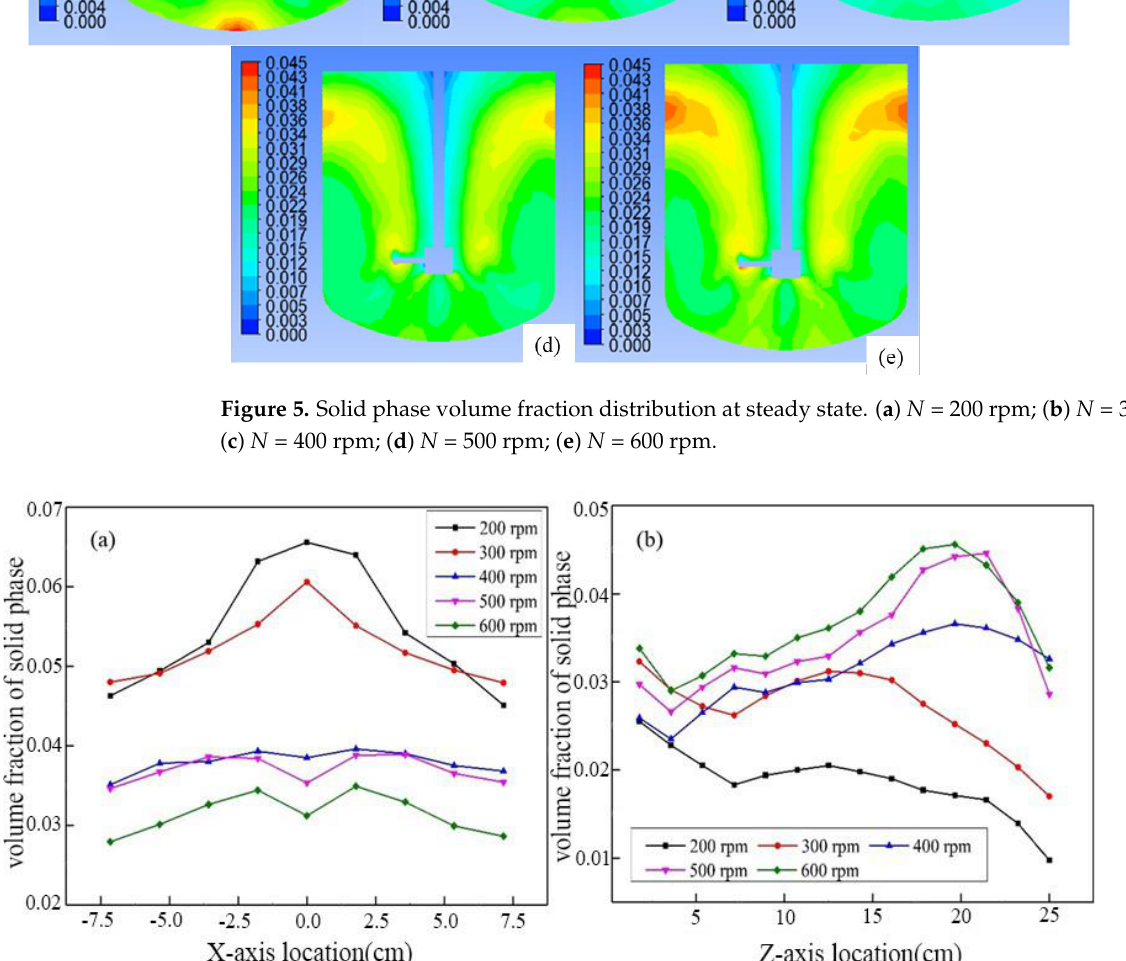
Figure 5. Solid phase volume fraction distribution at steady state. ( a ) N = 200 rpm; ( b ) N = 300 rpm; ( c ) N = 400 rpm; ( d ) N = 500 rpm; ( e ) N = 600 rpm.